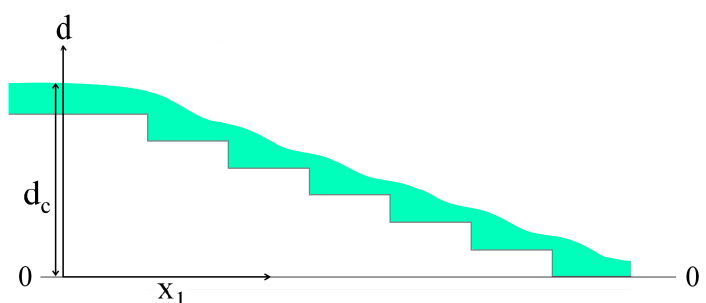
Figure 6. Water level diagram.